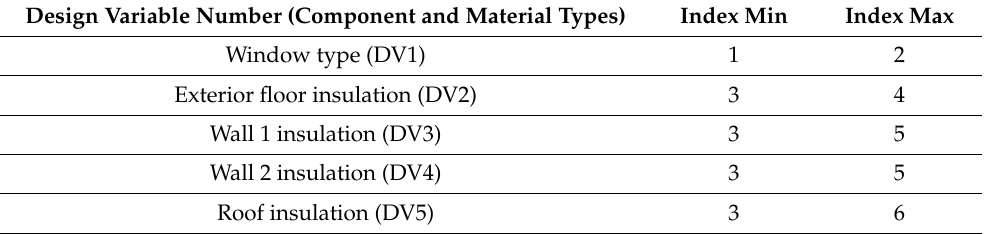
Table 3. The discrete variables and their ranges used as design variables in the optimization.